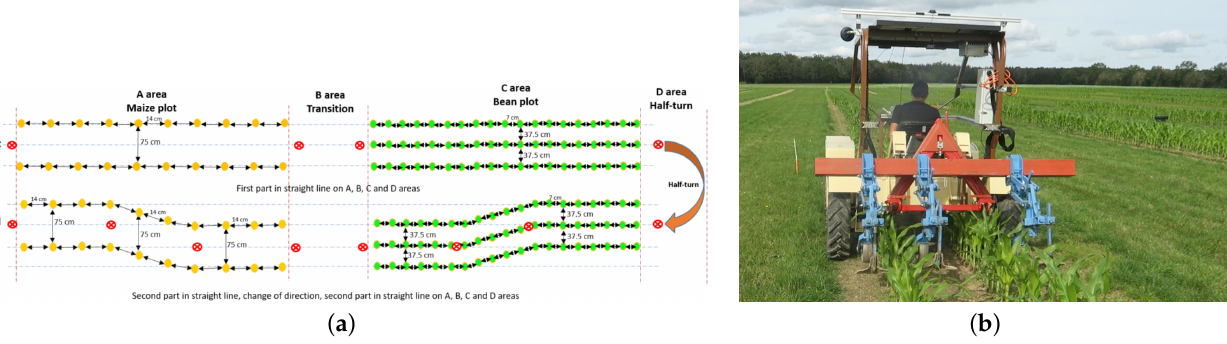
Figure 11. Presentation of experiment 2. ( a ) Scenario of the evaluation; ( b ) picture of the robot when it is following the curved maize